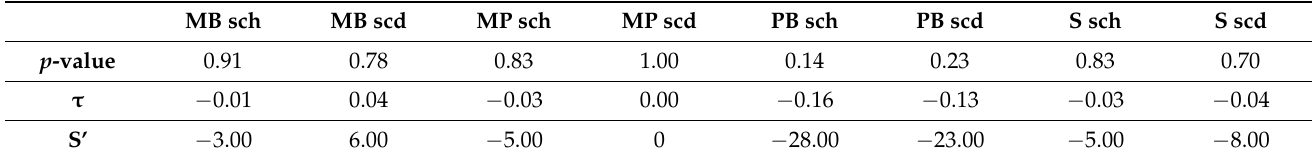
Table 3. Mann-Kendall seasonal test results, the alpha value has been set to 0.05; in bold the significant p -values; ( sch ), Average monthly snow cover height per day, days with snow cover per month (sc d ) for the weather stations ( MB , MP , PB , S